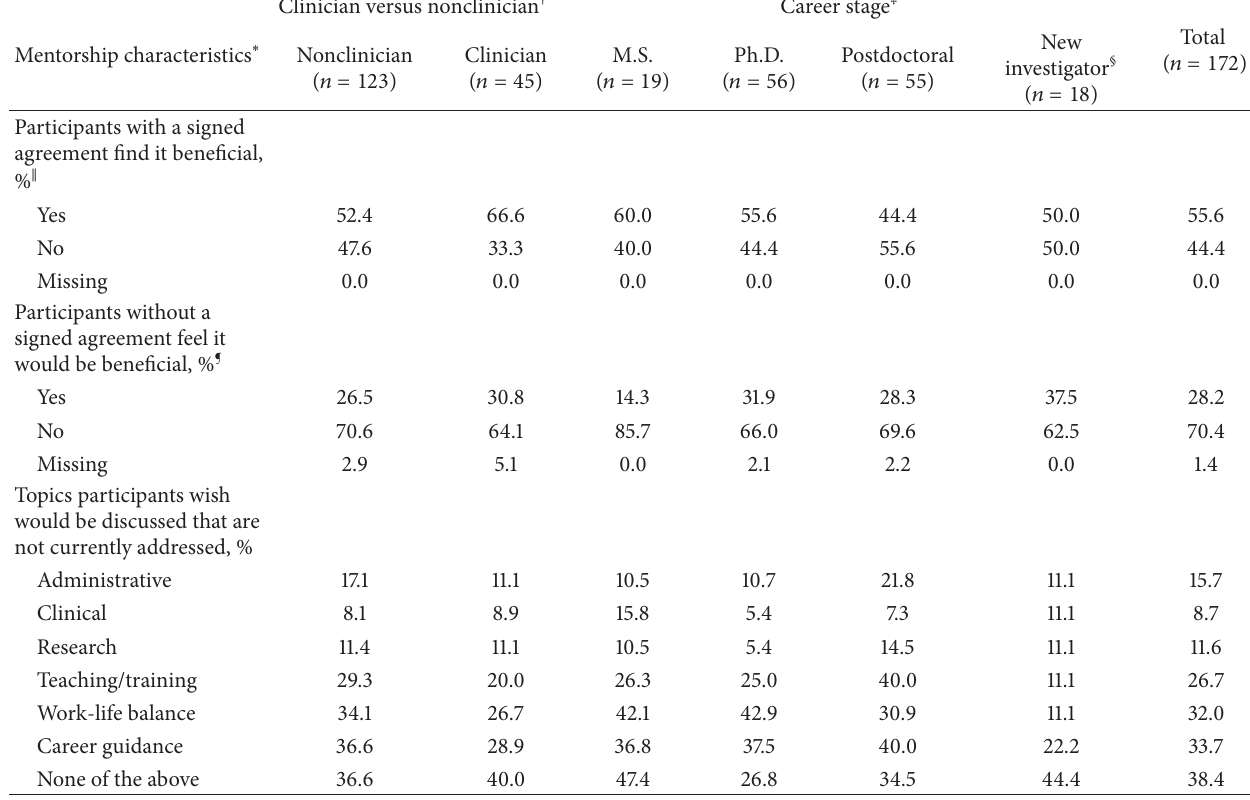
Table 4: Participant recommendations for improved mentoring